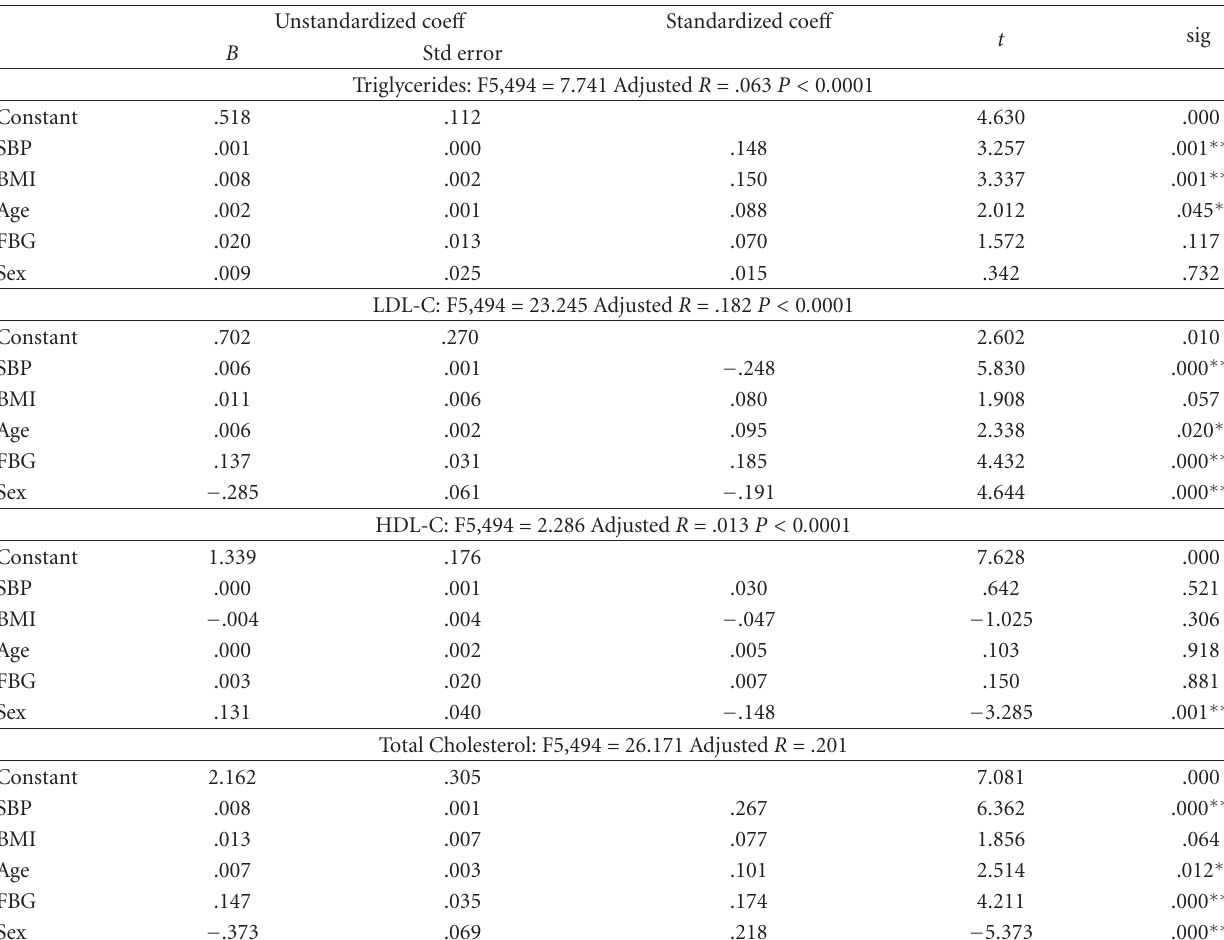
Table 4: Shows the multiple regression analysis with total cholesterol, HDL-C, LDL-C, and triglycerides as dependent variables and BP, age, BMI, sex, and FBG as independent